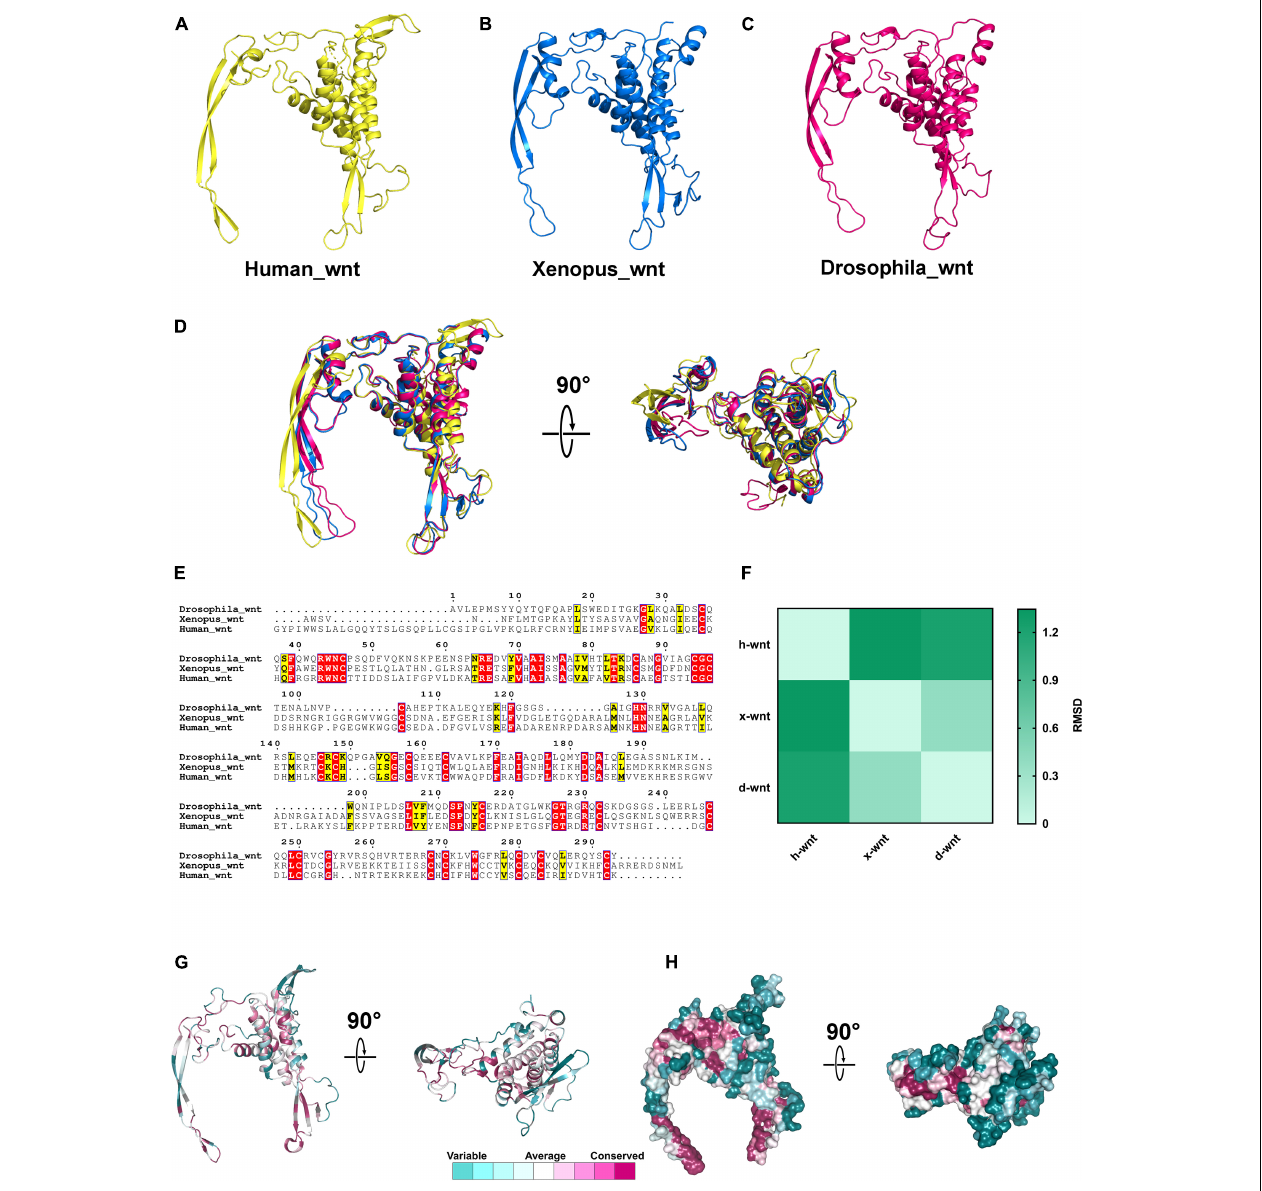
FIGURE 8 | The 3D structures of Wnt proteins in different species. (A–C) 3D structures of Wnt domains from humans, Xenopus and Drosophila . (D) Structural alignments of Wnt domains from different species; the colors correspond to panels (A,B,C) . (E) Amino acids sequences alignment of Wnt domains. (F) RMSD matrix of alignments of Wnt domains from different organisms. (G,H) Residue and surface conservation of the mouse Wnt